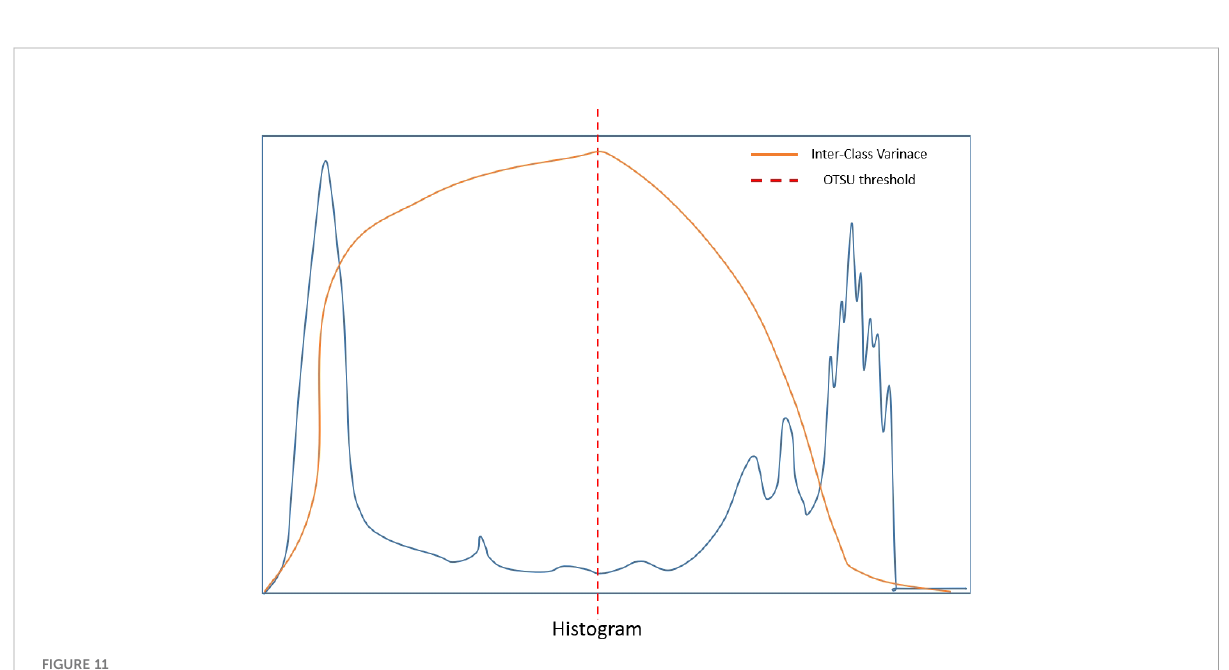
FIGURE 11 Histogram of the lesion